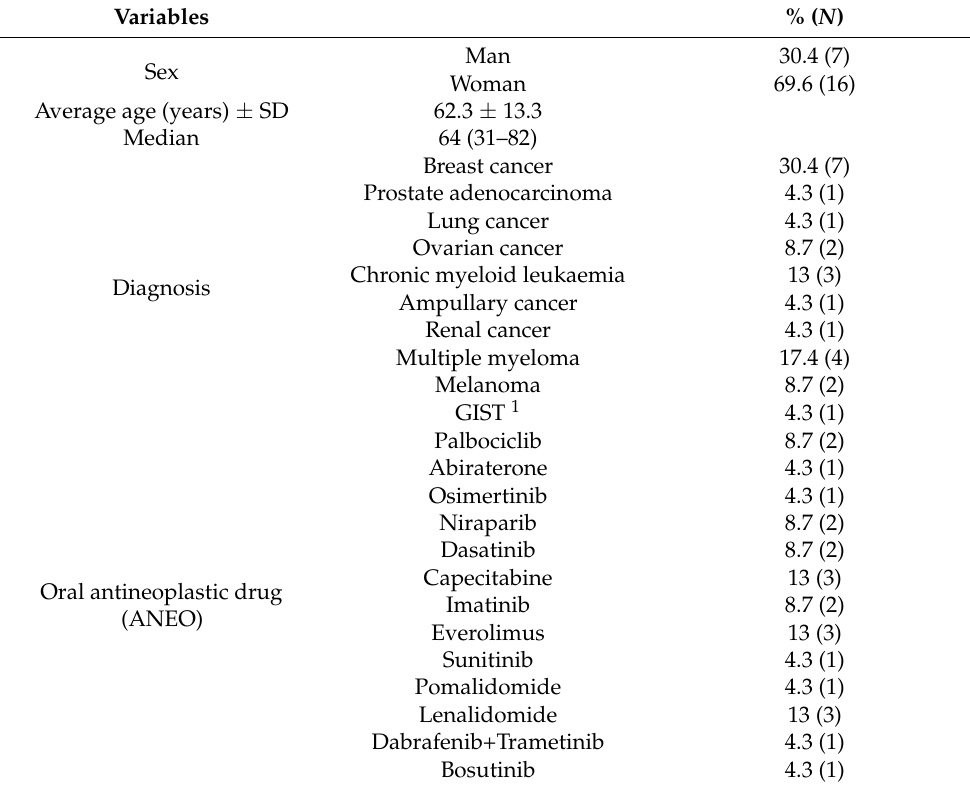
Table 1. Patients taking part in focus groups ( N = 23).